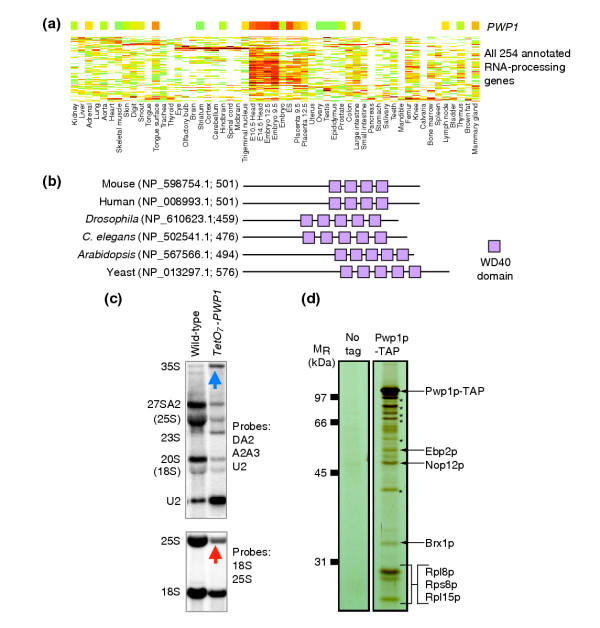
PWP1 functions in ribosomal large-subunit biogenesis. (a) The expression pattern of mouse Pwp1 is similar to that of most known RNA-processing proteins. (b) The domain structures of Pwp1 homologs identified by BLASTP searches. Accession number and amino-acid length is given. We identified a single strong match in each of the species shown. Domains were identified by CDD search [29]. (c) A northern blot showing the accumulation of 35S rRNA precursor (blue arrow), reduction in other rRNA precursors (top panel), and reduction in 25S rRNA (red arrow) in the yeast TetO7-PWP1 mutant (strain TH_2220) in comparison to the parental wild-type strain (R1158) [9]. The U2 spliceosomal RNA is shown for comparison; its apparent abundance is increased because 5 μg RNA was loaded per lane, and the relative proportion of rRNA to snRNA is decreased in the mutant. Blotting procedures and probes were as previously described [9]. (d) Affinity-purification of yeast Pwp1p-TAP reveals association with proteins known to function in ribosomal large-subunit biogenesis (Ebp2p, Nop12p, Brx1p) as well as a subset of ribosomal proteins. The asterisks mark degradation products of Pwp1p-TAP.